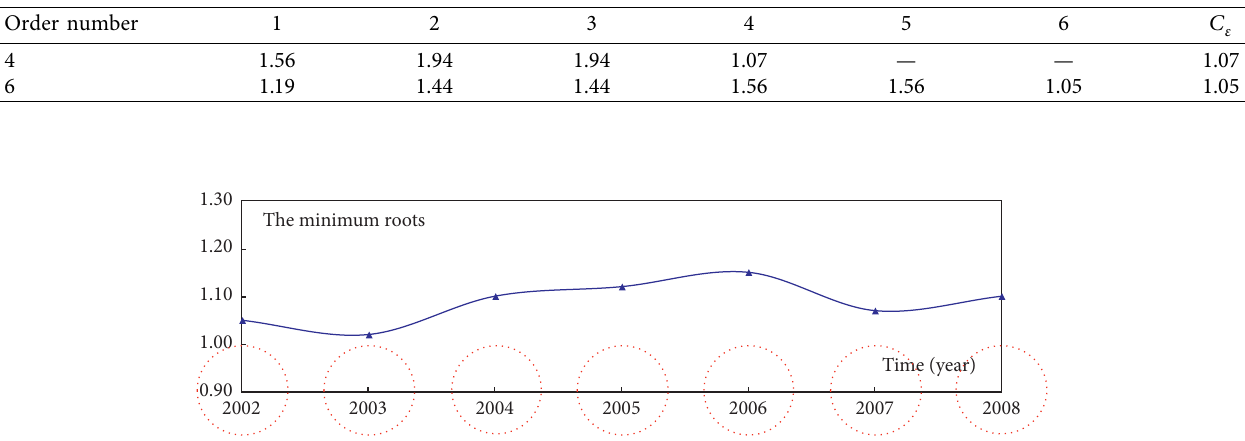
Table 1: Calculation results of characteristic roots and the minimum root.